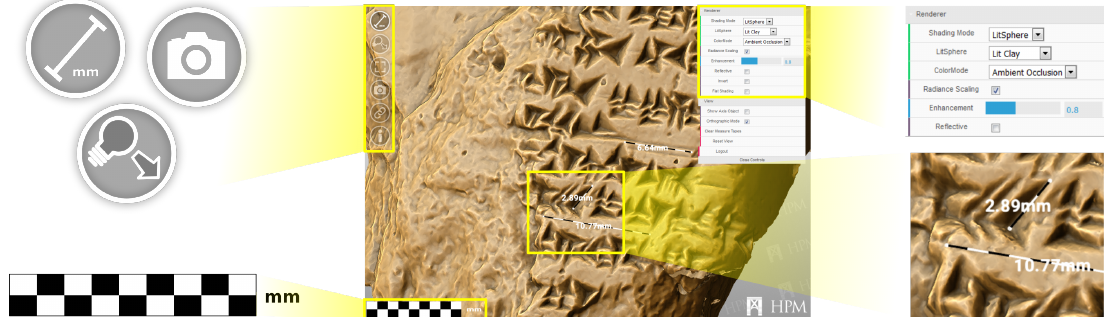
Figure 6. The graphical user interface of the framework, including quick access buttons on the top left, the dat.GUI [42] based configuration of the rendering pipeline on the top right, the dynamic scale object at the bottom left and several measurement tapes on the